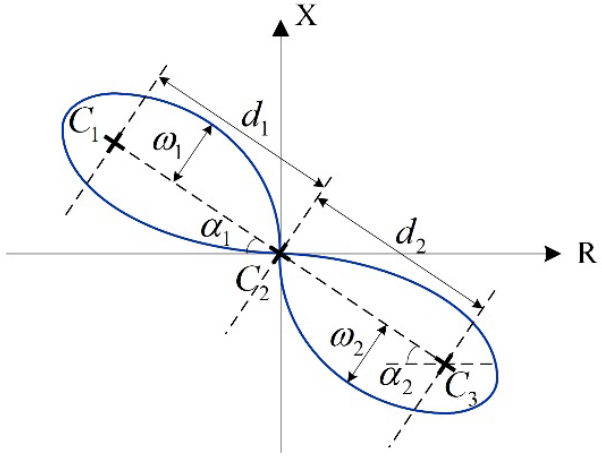
, , and are Figure 19. Geometric features of the Lissajous curve in the impedance plane. C 1 , C 2 , and C 3 are 𝐶𝐶 1 𝐶𝐶 2 𝐶𝐶 3